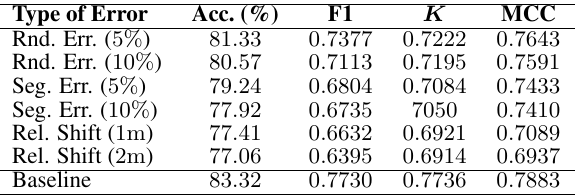
Overall, the label errors affect the model’s ability to general- ize and make it harder to infer the contextual patterns